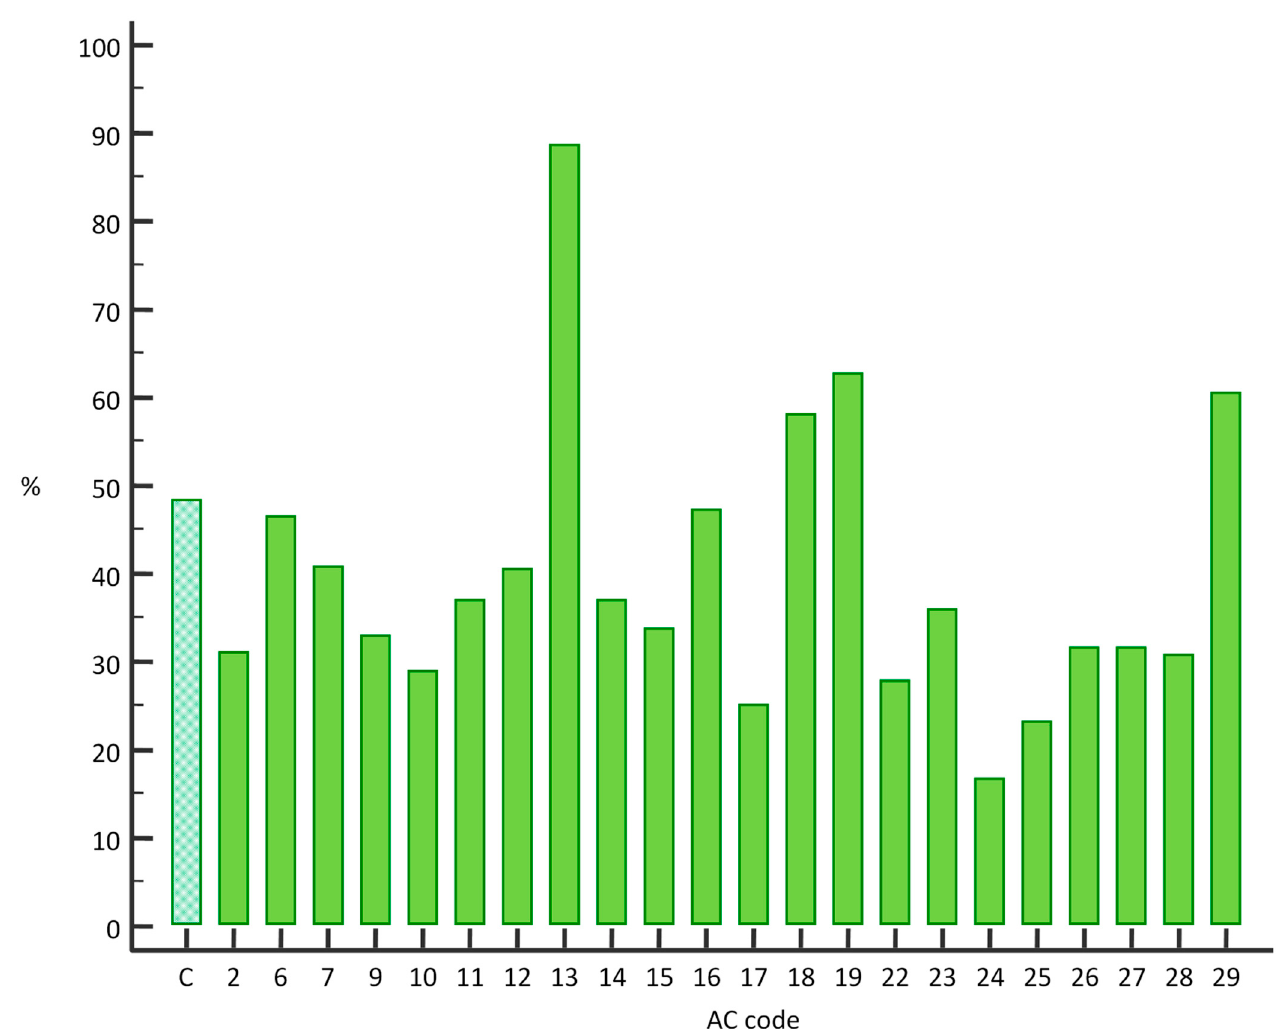
Figure 2. Percentage of samples with detected specific autoantibodies using Theradiag FIDIS™ connective profile in patients with particular rare IIF patterns determined using indirect immunofluorescence assay on HEp-2 cells in 1:100 dilution. C = comparison group.